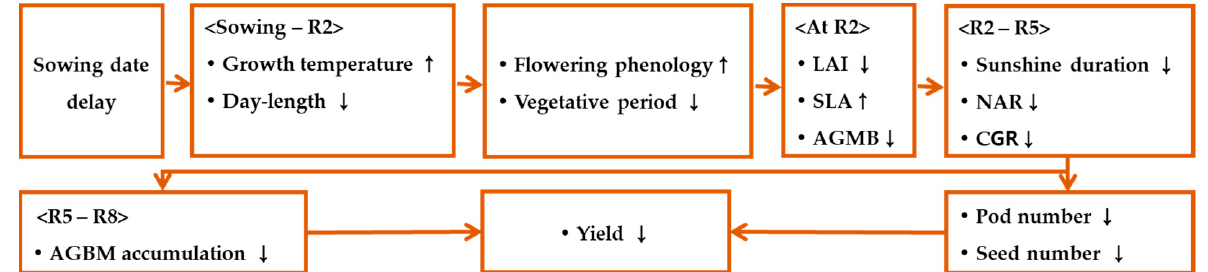
Figure 7. A diagram illustrating the hypothetical process of yield reduction due to late sowing of double-crop soybean grown in drained paddy fields at temperate monsoon zone. Upward and downward arrows refer to increase and decrease in related parameters, respectively. R2, flowering; LAI, leaf area index; SLA, specific leaf area; AGBM, aboveground biomass, R5, beginning of grain filling; NAR, net assimilation rate; CGR, crop growth rate; R8,